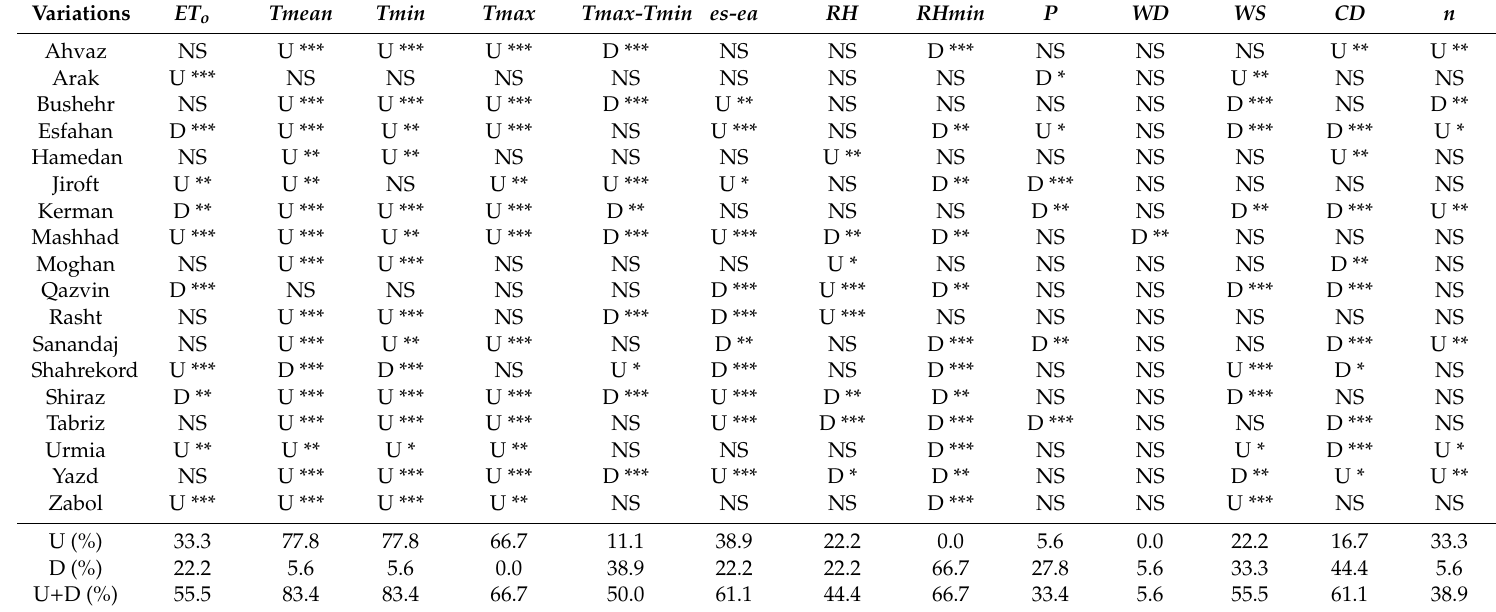
Table 3. Trends of Agricultural Organization of the United Nation (FAO)-Penman–Monteith (FPM) evapotranspiration ( ET o ) estimates and 12 meteorological variables in the 18 study sites. U and D represent the significant upward and downward trends, respectively. NS denotes no significant